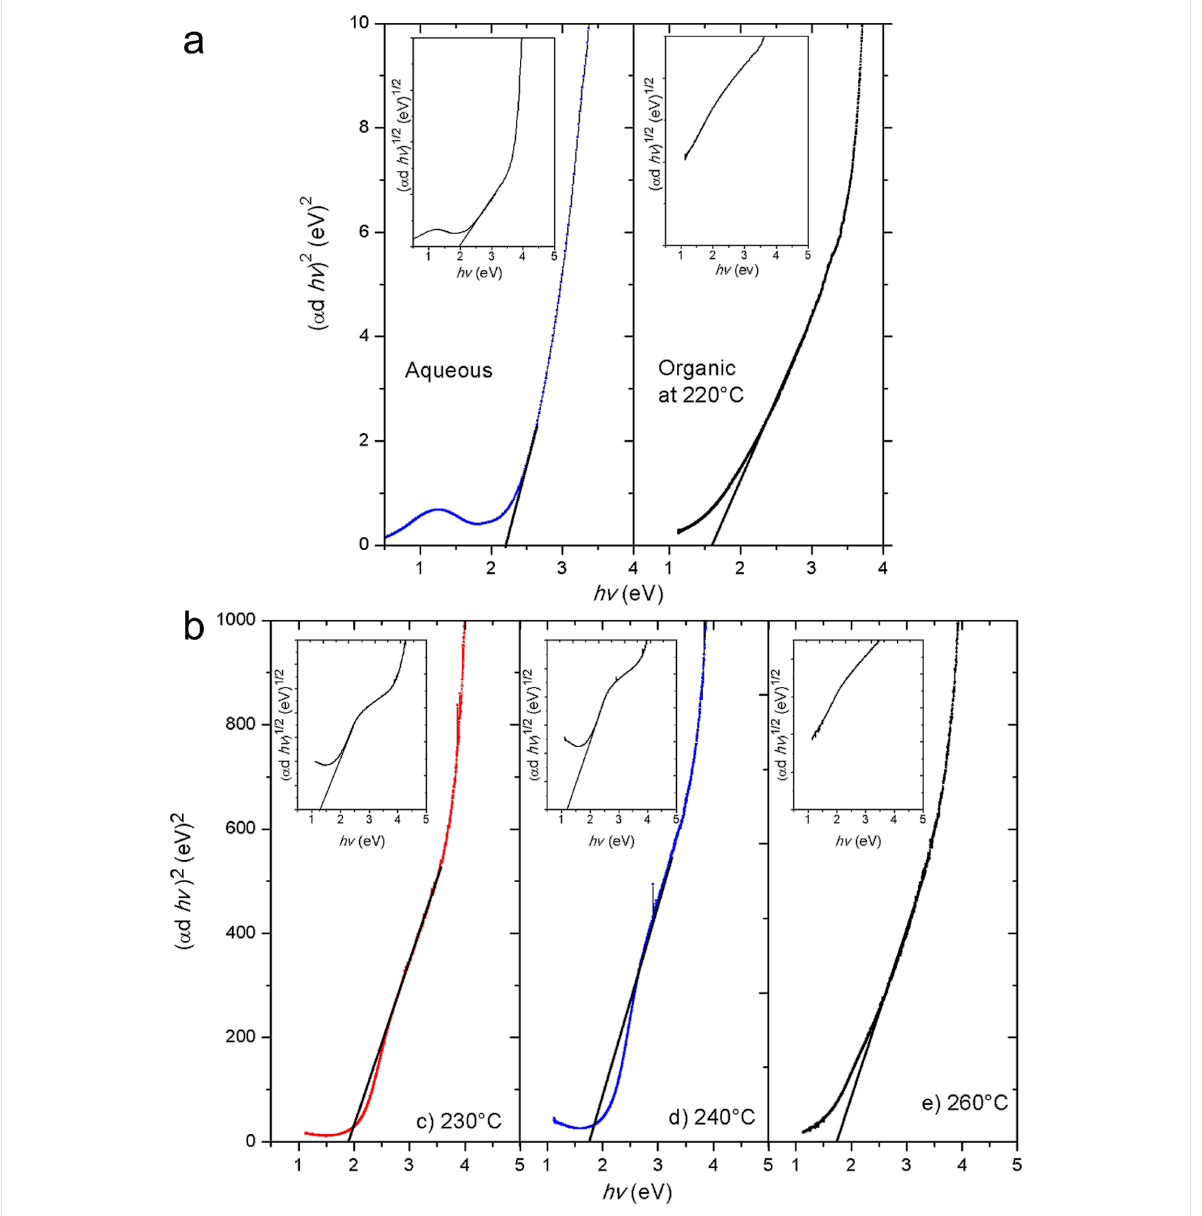
Figure 5: Direct band gaps of copper sulfide in a) amorphous phase obtained by aqueous synthesis and b) crystalline phases from organic media. Indirect band gap plots are included as an inset in all plots. The clear slopes in the graphics show the direct band gap energy.